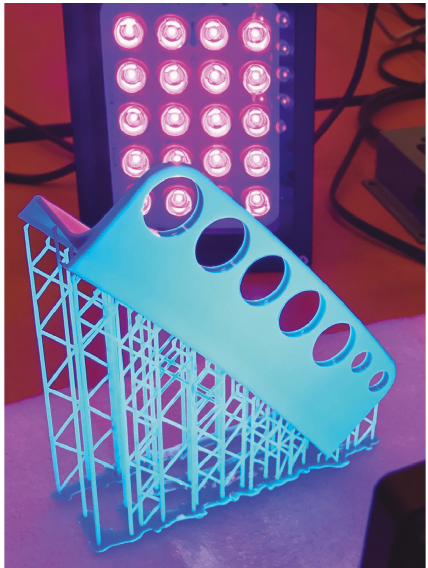
Figure 1: Prototype syringe bracket with removable support structures printed with a desktop stereolithography 3D printer.